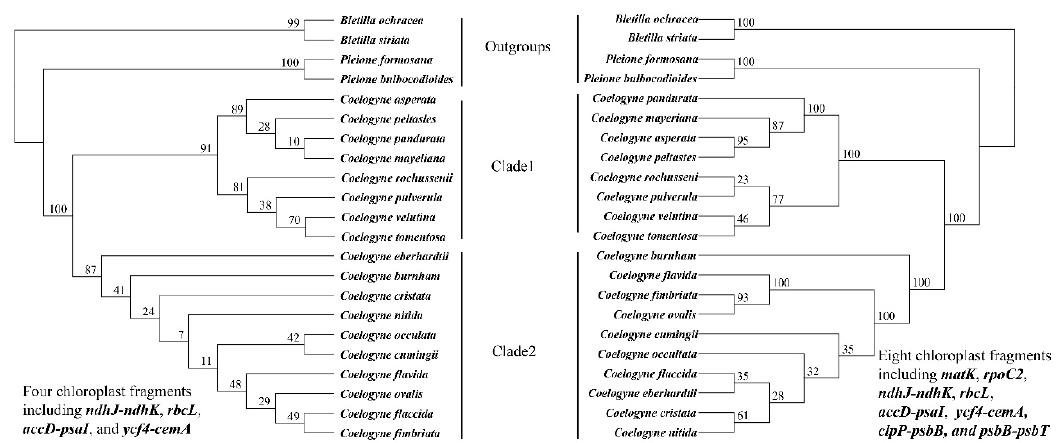
Figure 6. The Phylogenic relationship of 18 Coelogyne species with Maximum Likelihood (ML) analysis using four (left) and eight (right) chloroplast fragments, respectively. The number in the node showed the bootstrap support in the ML method using the RAxML software.